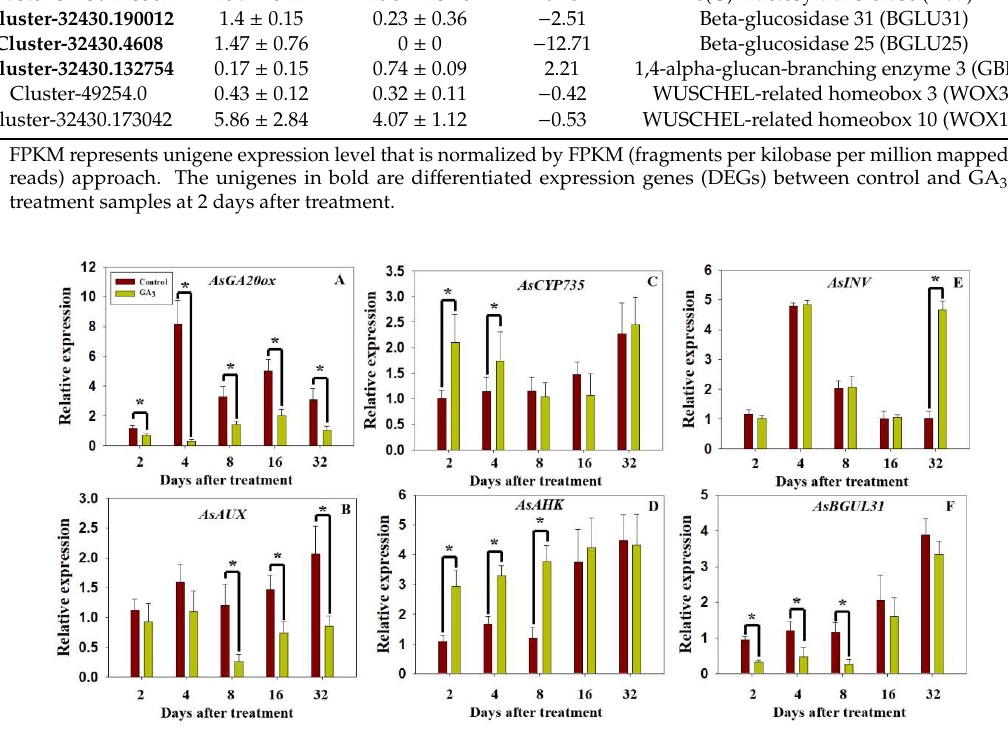
Figure 5. The expression of six key unigenes in stems under GA 3 treatment versus control (water treatment) at 2, 4, 8, 16 and 32 DAT: ( A ) AsGA20ox , ( B ) AsAUX , ( C ) AsCYP735 , ( D ) AsAHK , ( E ) AsINV and ( F ) AsBGLU31 . Data represent mean ± SD of three biological replicates, with transcripts normalized to Allium sativum actin . DAT, days after treatment. Significance level: * p < 0.05.